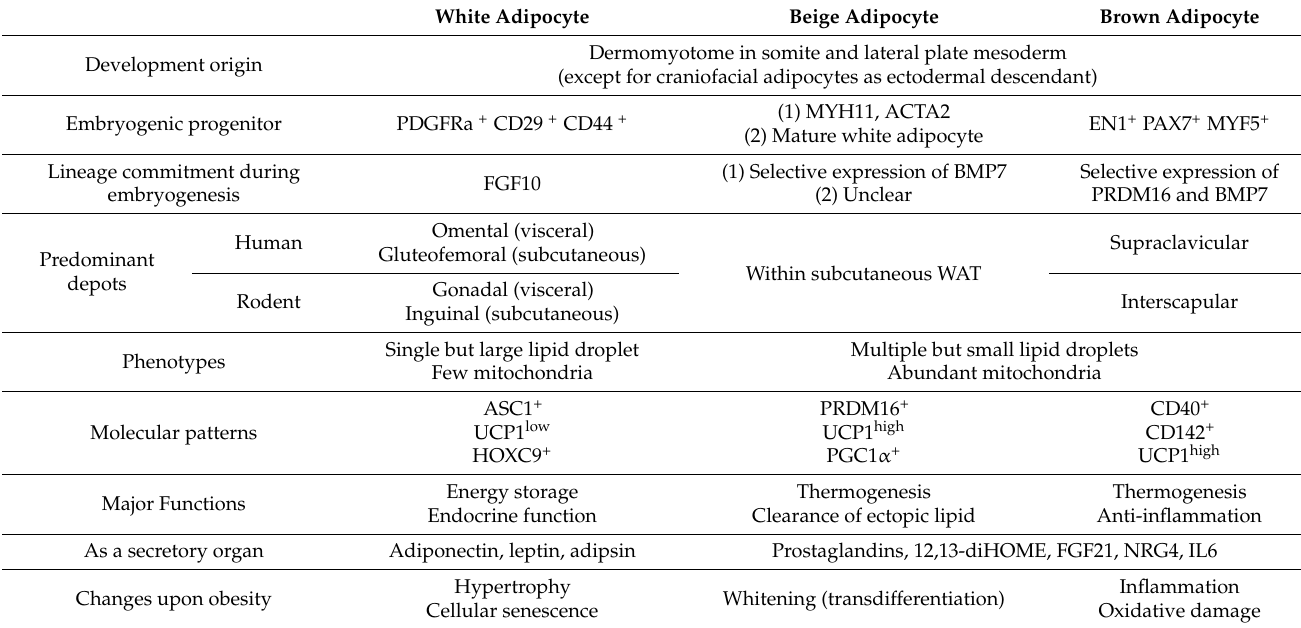
Table 1. Overview of adipocyte